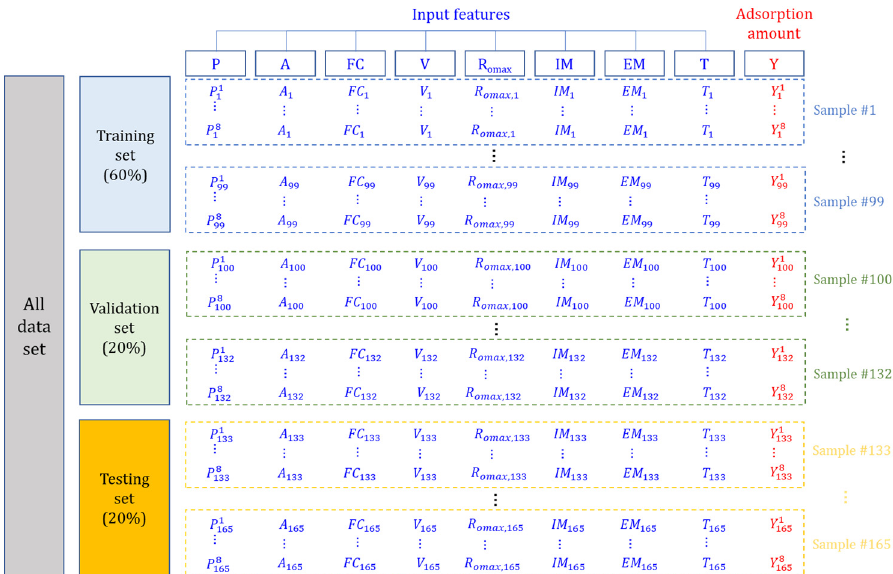
Figure 5. Illustration of the database structure and division of the database into the training, validation and testing sets. P—equilibrium pressure; A—ash; FC—fixed carbon; V—vitrinite; R omax —vitrinite reflectance; IM—inherent moisture; EM—equilibrium moisture; T—temperature; Y—adsorption amount. Subscript j denotes the j th sample; Superscript i on “P” and “Y” denote the i th equilibrium point on the adsorption isotherm.